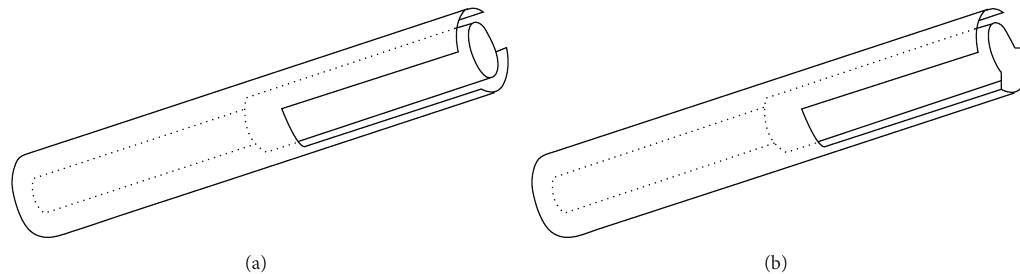
Figure 1: Split coaxial balun with a step-transition of the inner conductor: (a) waveguide transition from coaxial line to double-slotted coaxial line and (b) the same transition terminated with a short circuit at the double-slotted line side.